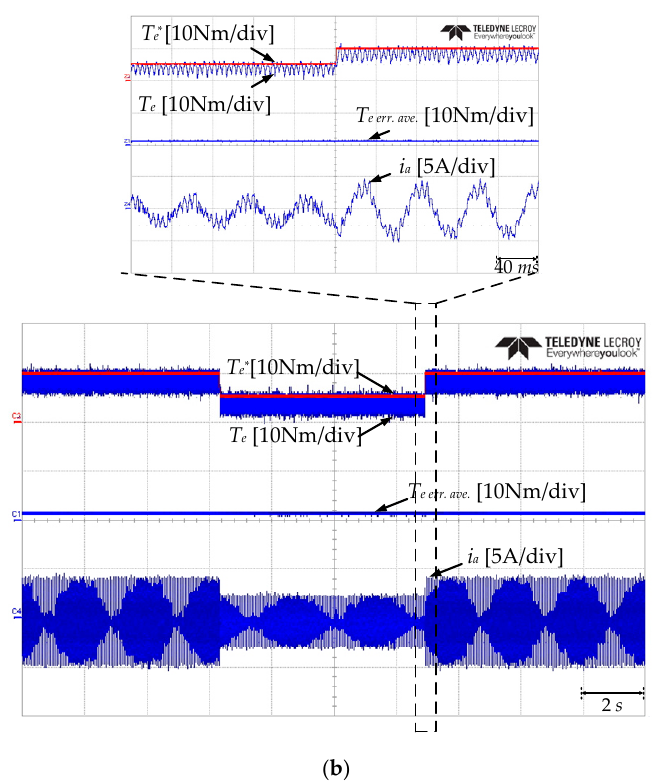
Figure 14. Experimental results of the transient-state operation at 400 r / min: ( a ) conventional four-level HTC; ( b ) proposed four-level HTC.